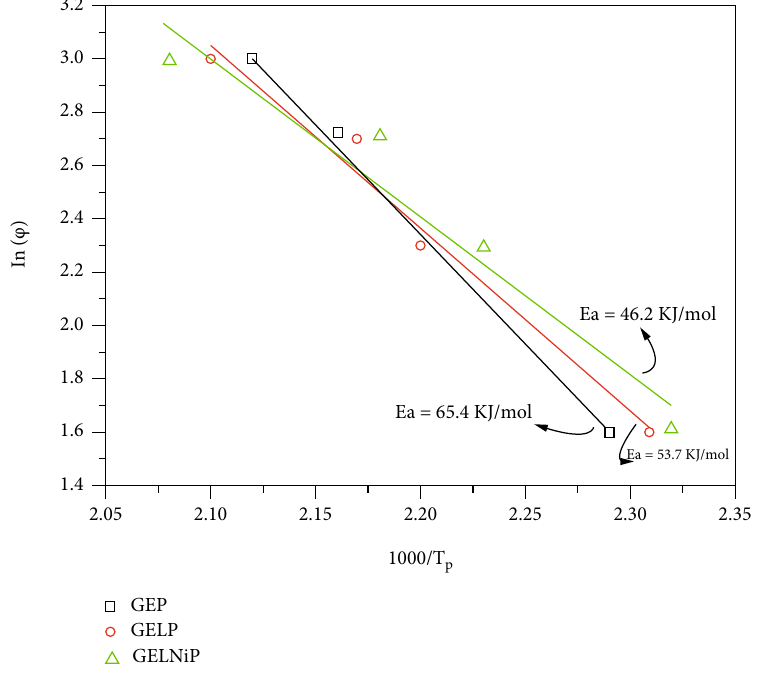
Figure 7: Plots of ln(Ø) vs. 1/T for GEP, GELP, and GELNiP nanocomposites derived from FWO